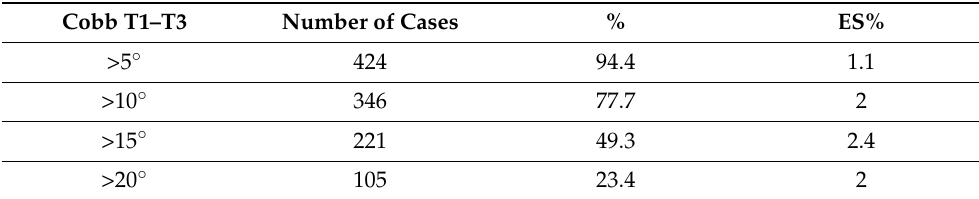
Table 1. Treatment efficacy.